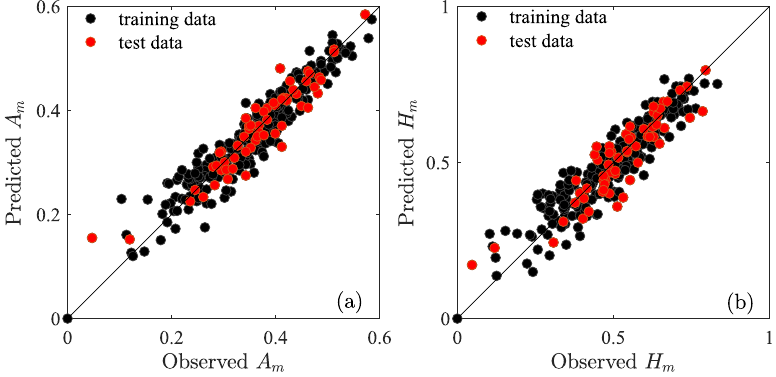
Figure 11. Predicted ( a ) A m and ( b ) H m with a six–eight–two ANN model versus experimental data. Training data and test data in the ANN model are displayed